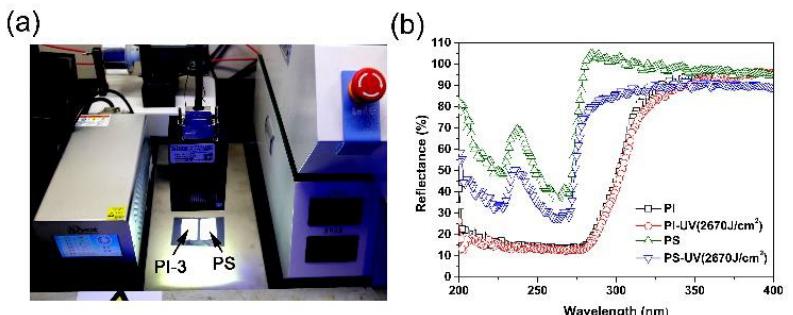
Figure 12. UV-Vis plots of polymer membranes after UV radiation (365 nm) treatment. ( a ) UV exposure test; ( b ) UV-Vis reflectance plots in the wavelength range of 200~400 nm.